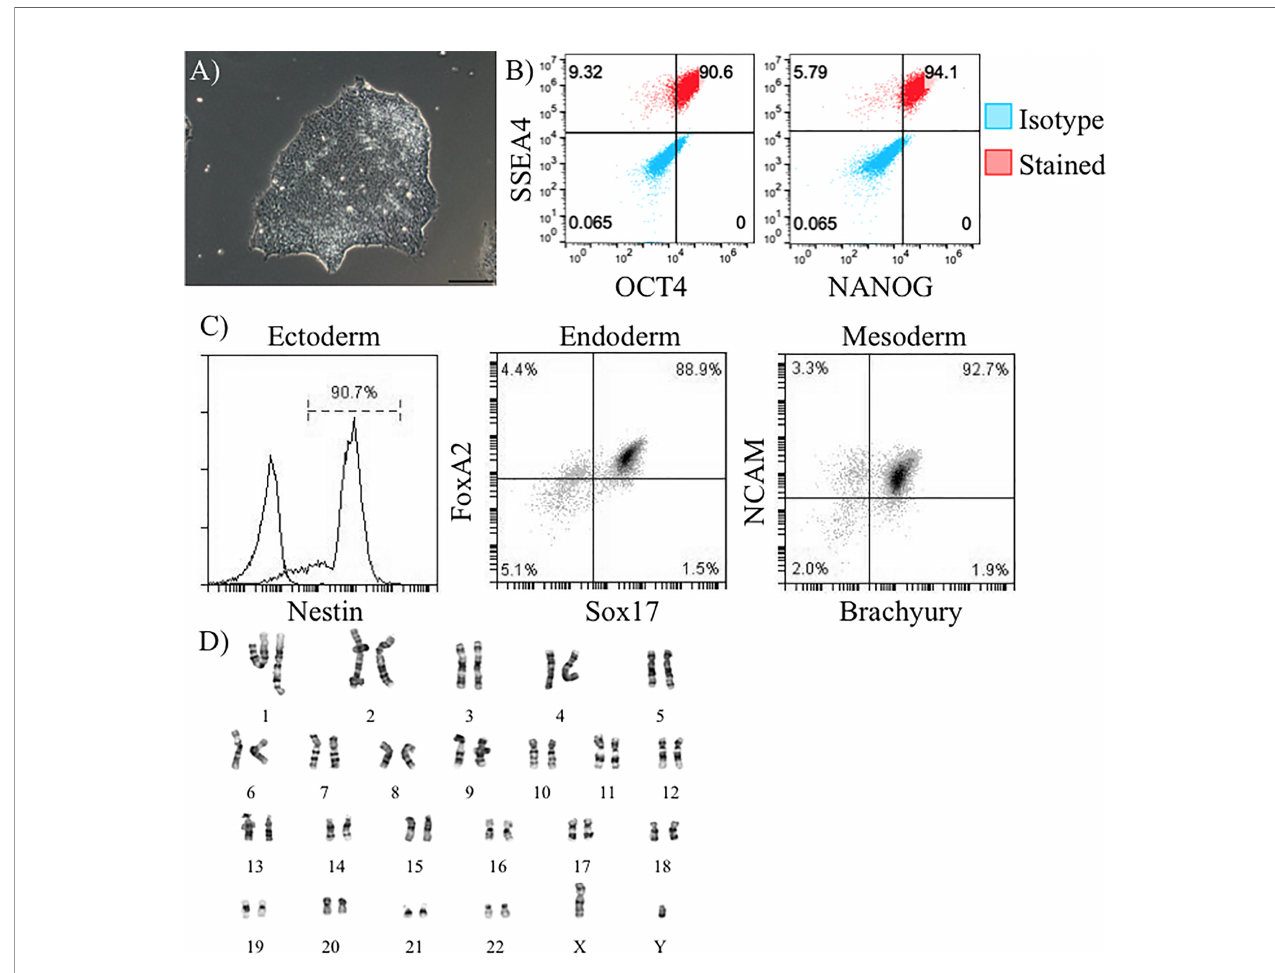
FIGURE 2 | Veri fi cation of pluripotency of donor 2395 iPSC. (A) A phase contrast image of an iPSC colony from donor 2395 showing densely packed cells with a de fi ned border characteristic of iPSC. (B) Donor 2395 iPSC are positive for Oct4, SSEA4, and NANOG expression. (C) Donor 2395 iPSC express Nestin when differentiated to ectoderm, express FoxA2 and Sox17 when differentiated to endoderm, and express NCAM and Brachyury when differentiated to mesoderm. (D) Karyotypic analysis of donor 2395 iPSC reveals a normal